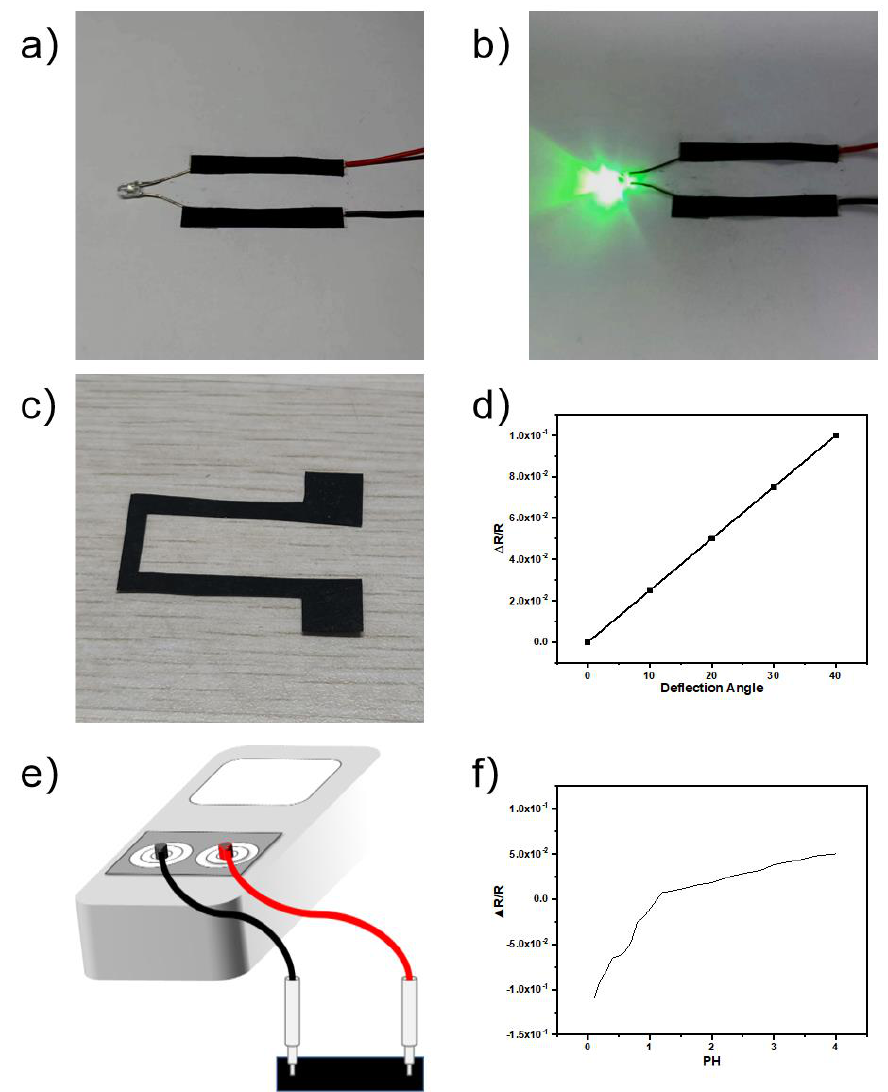
Figure 15. Three paper-based devices ( a , b ) Conductive paper as electrodes in a LED light device. ( c , d ) A simple accelerometer design made of the conductive paper, and the resistance change upon bending of the paper device. ( e , f ) Monitoring the resistance value of the paper base deposited, and the resistance change upon pH of the paper device.